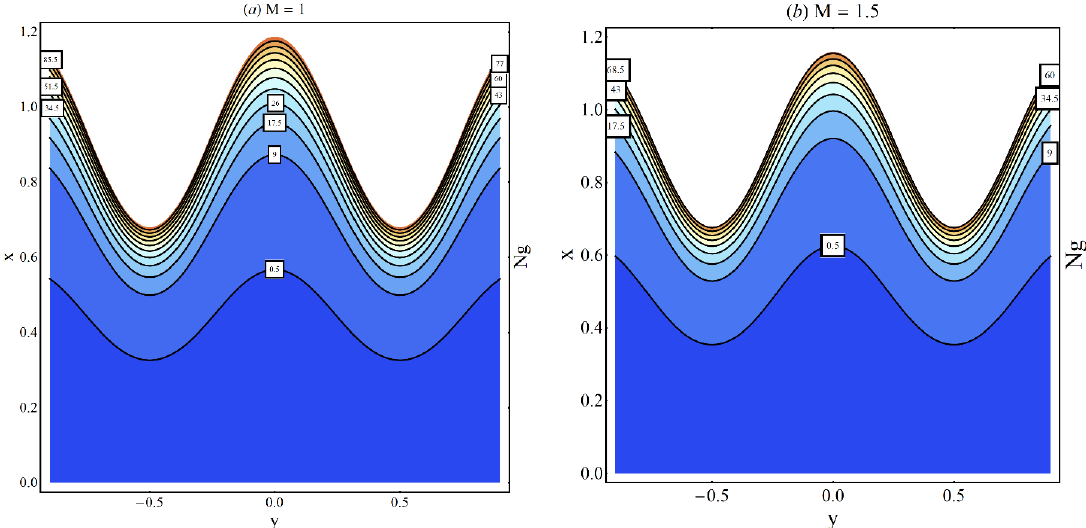
Coatings 2020 , 10 , x; doi: FOR PEER REVIEW Figure 15. Entropy lines at two different values of M: (a) M = 1 and (b) M = 1.5. Figure 15. Entropy lines at two different values of M: (a) M = 1 and (b) M = 1.5. Figure 15. Entropy lines at two di ff erent values of M: (a) M = 1 and (b) M = 1.5.